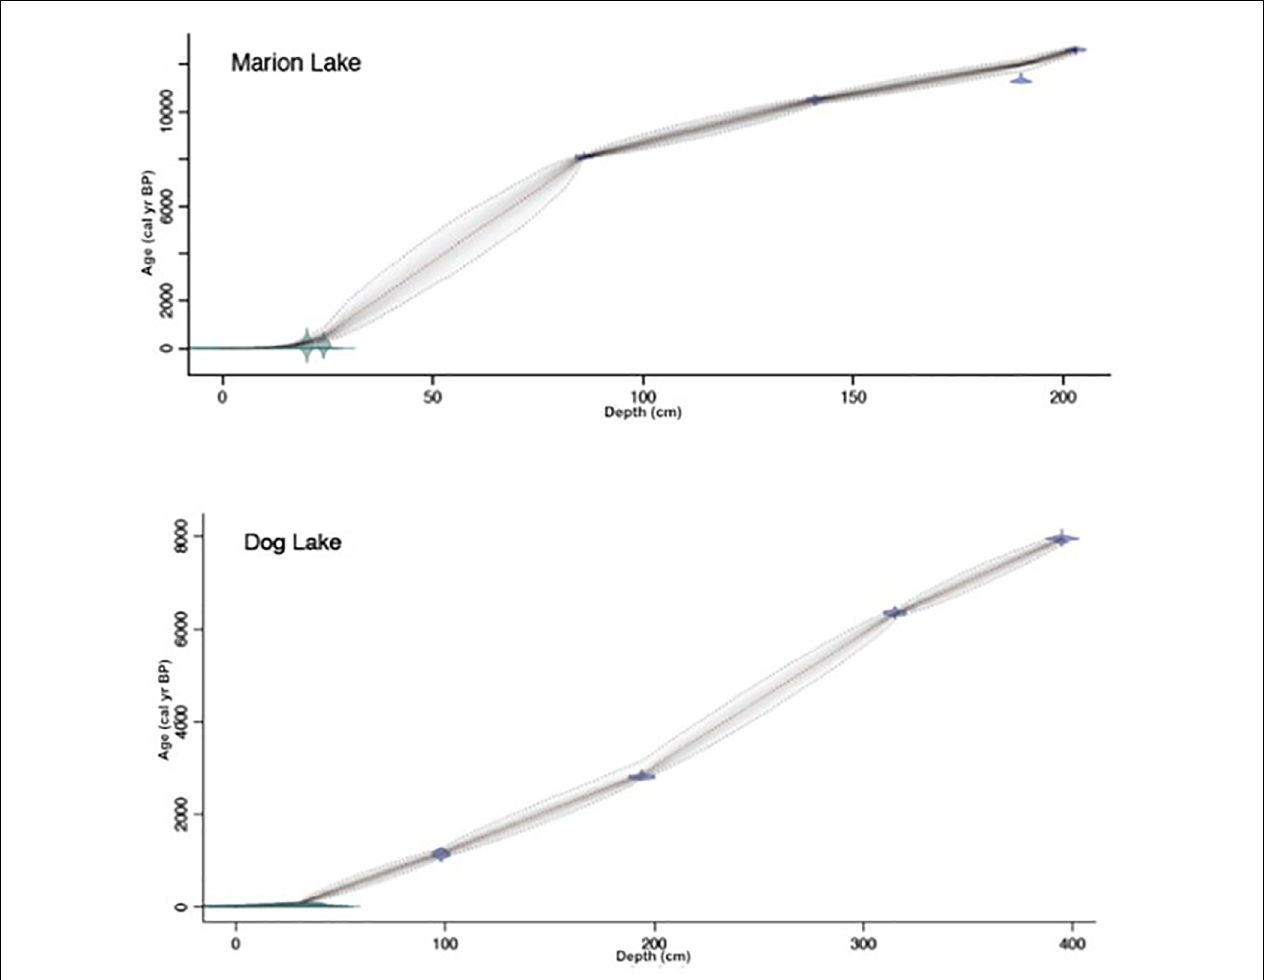
FIGURE 2 | Marion Lake age-vs.-depth relationship (A) and Dog Lake age-vs.-depth relationship (B) . The likelihood the model runs through a sample (points with errors) in grayscale, where the darker the gray, the more likely the model runs through that sample.